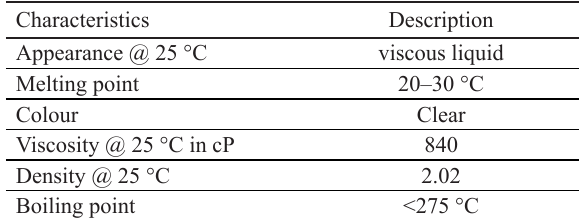
Table 3. Characteristics of polyphosphoric acid of the study